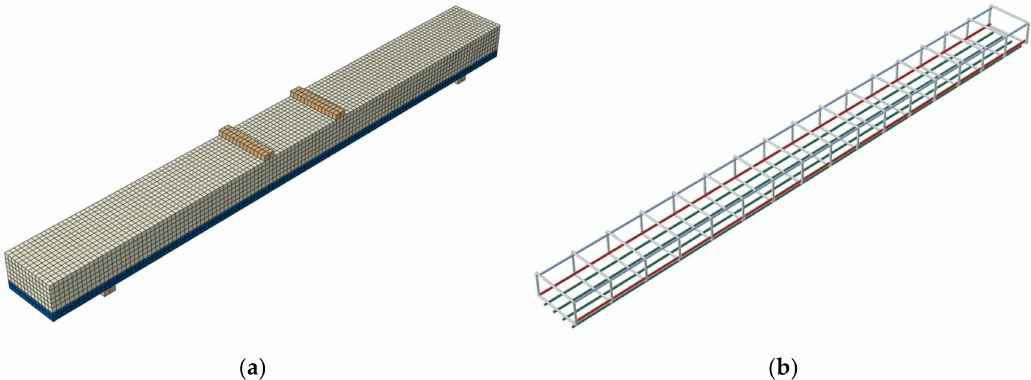
Figure 8. Mesh configuration for ( a ) concrete and ( b ) steel reinforcement.